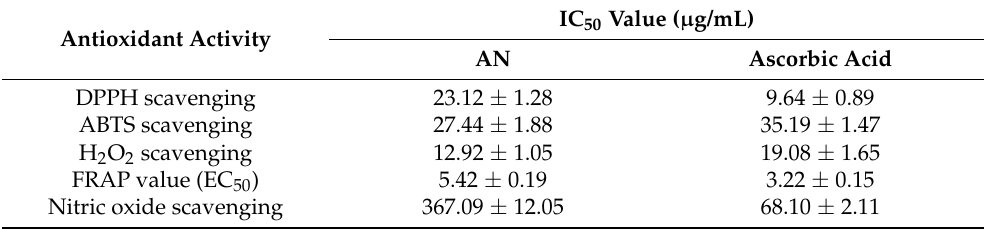
Table 6. In vitro antioxidant activities of A. nilagirica extract (AN) expressed as IC 50 values ( µ g/mL).